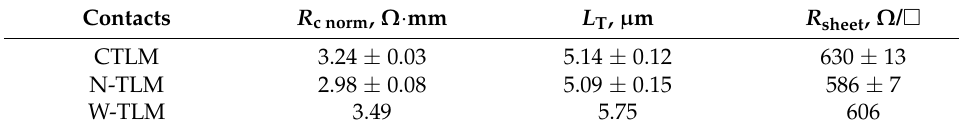
Table 1. Contact resistance, transfer length, and sheet resistance of the GaN epilayer.